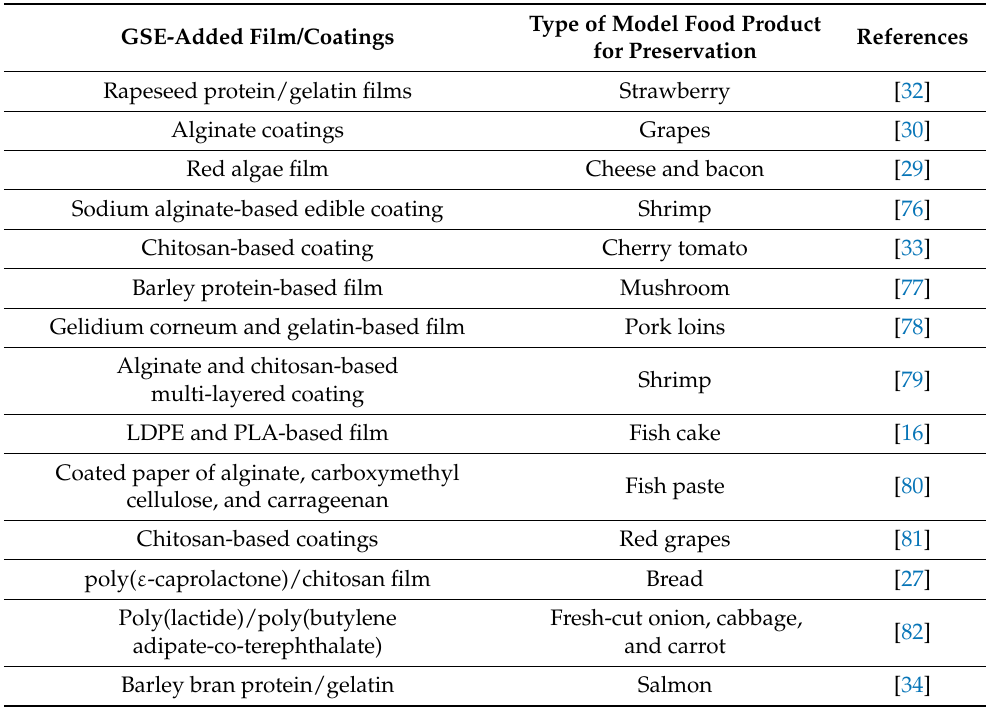
Table 2. GSE-incorporated films/coatings for food packaging